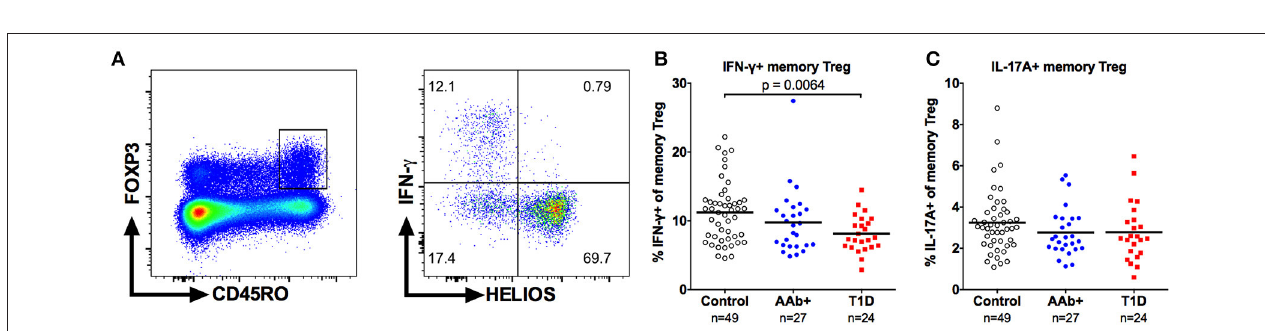
FIGURE 8 | Decreased frequency of IFN- γ -producing memory Tregs in children with newly diagnosed T1D. Representative example of IFN- γ production by CD4 + CD25 + FOXP3 + HELIOS-CD45RO + memory Tregs (A) . Frequencies of IFN- γ - (B) and IL-17A-producing (C) memory Tregs in control, AAb + and T1D groups.